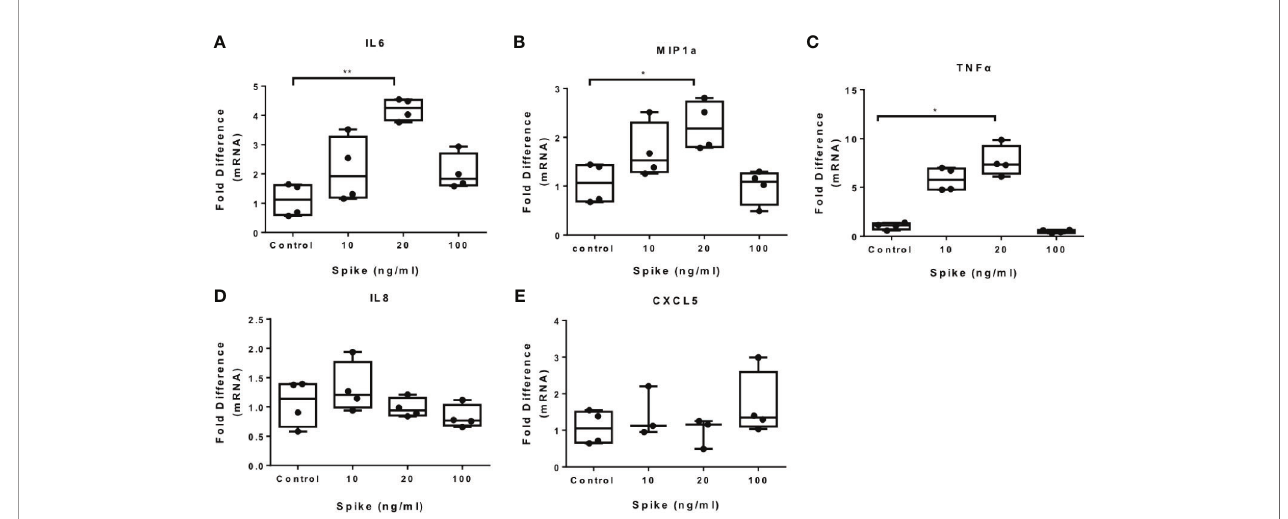
FIGURE 1 | SARS-CoV-2 S protein induces pro-in fl ammatory cytokine and chemokine expression in THP-1 macrophages. THP-1 macrophages were treated with different concentrations of SARS-CoV-2 Spike-Membrane recombinant fusion protein (10, 20, 100 ng/ml) for 12 hours. (A – E) mRNA expression of IL6, MIP1a, TNF a , IL8 and CXCL5 was measured. Data are illustrated in box-and-whiskers and plotted as median (± min, max). Statistical analysis was performed with Kruskal - Wallis test. *p < 0.05, **p <